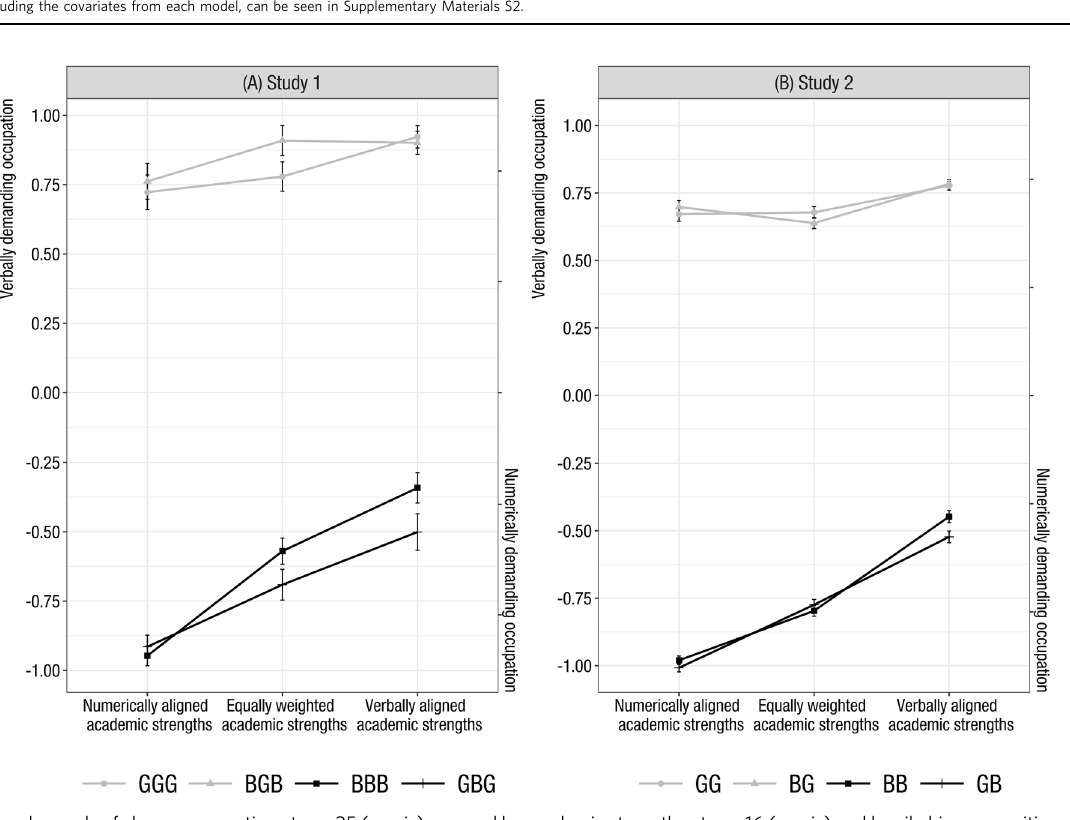
Fig. 2 Cognitive demands of chosen occupation at age 35 ( y -axis) grouped by academic strengths at age 16 ( x -axis) and by sibship composition among girls (coloured in grey) and boys (coloured in black) in A Study 1, and B Study 2. GGG = mid-born girls with younger and older sisters; BGB = mid-born girls with younger and older brother; BBB = mid-born boys with younger and older brothers; GBG = mid-born boys with younger and older sisters. GG = last-born girls with older sister; BG = last-born girls with older brother; BB = last-born boys with older brother; GB = last-born boys with older sister. Whiskers represent standard error of the